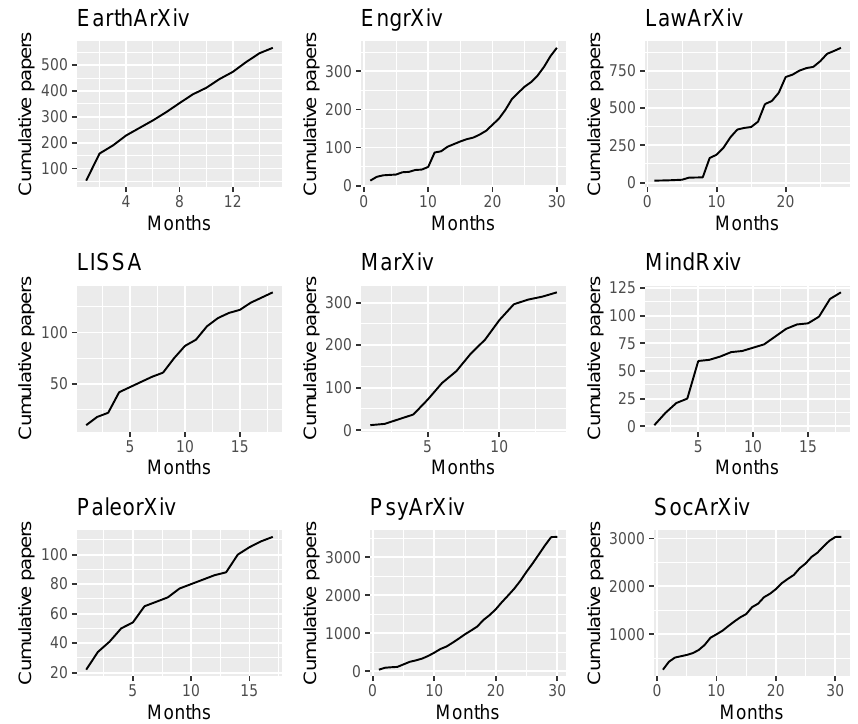
Figure 1. Cumulative paper submissions for the 9 services, data is recorded monthly. Note that values on both the X axis (Cumulative paper submission count) and Y axis (months since founding) are different for each panel. Each service will vary based on discipline specific paper production